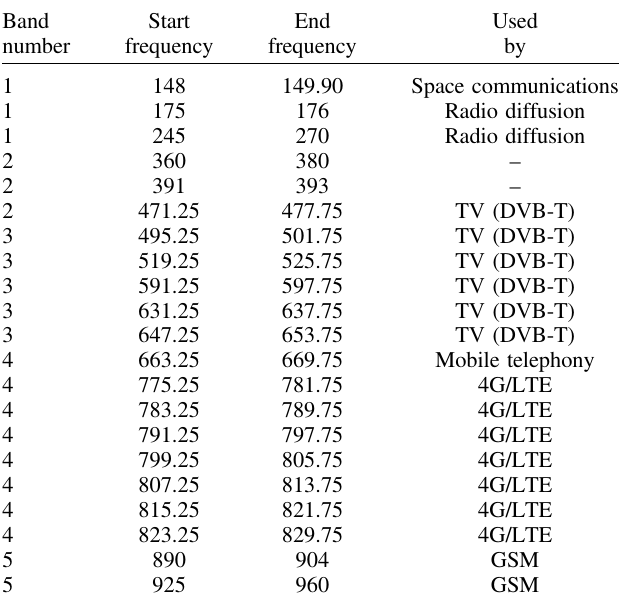
Table 2. Radio frequency interference in the ORFEES frequency range and its users: 4G/LTE (Long Term Evolution), DVB-T (Digital Video Broadcasting Terrestrial), GSM (Global System for Mobile